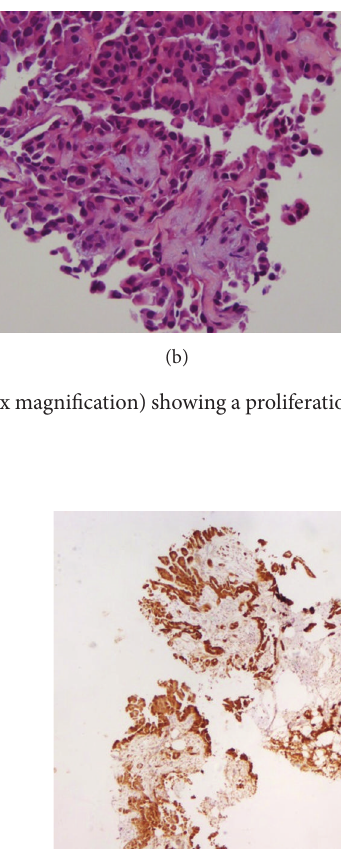
Figure 4: Calretinin immunohistochemical stain (5x magnifica- tion) is positive in mesothelial